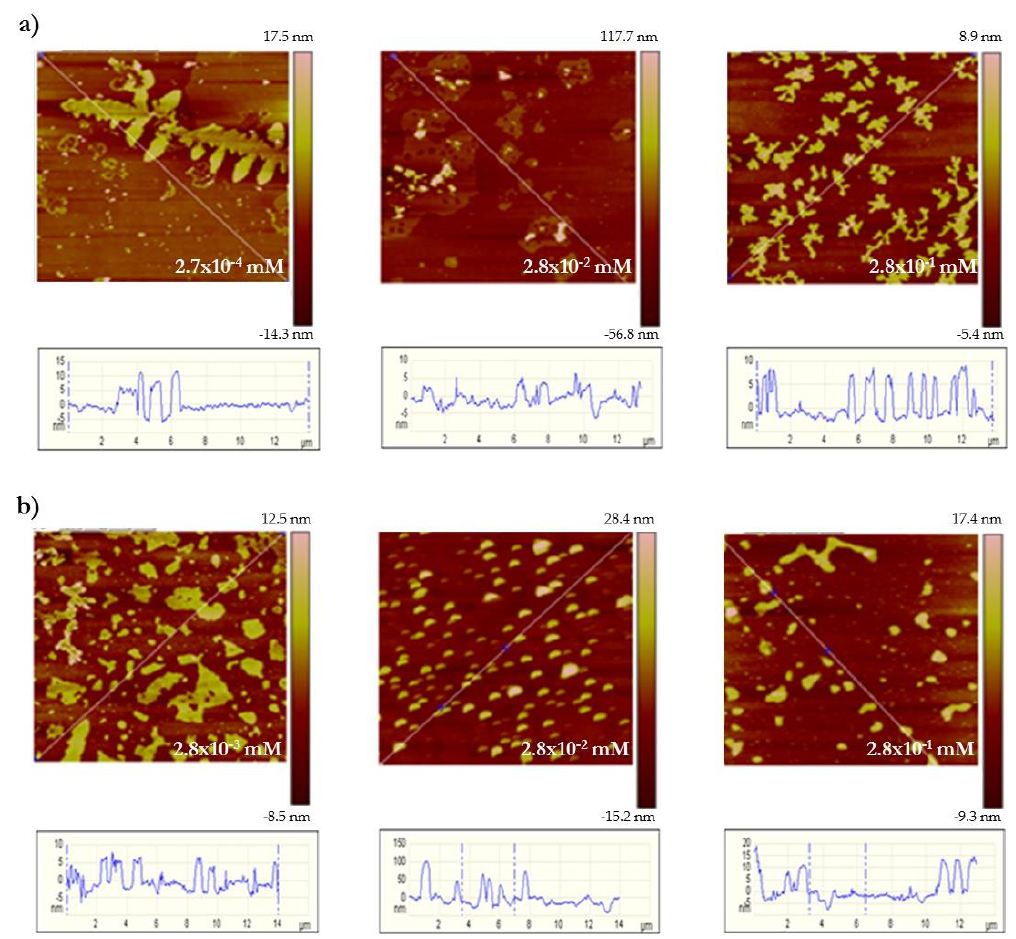
Figure 6. AFM images (tapping mode, 10 × 10 µm 2 ) obtained for layers obtained for the deposition of DSPE-PEG+surfactant mixtures containing different surfactant and solution concentration: ( a ) SLES and ( b ) SLMI. All the mixtures contain a fixed DSPE-PEG concentration of 5 g / L, and their ionic strength and pH were fixed a 40 mM (KCl) and 5.6,